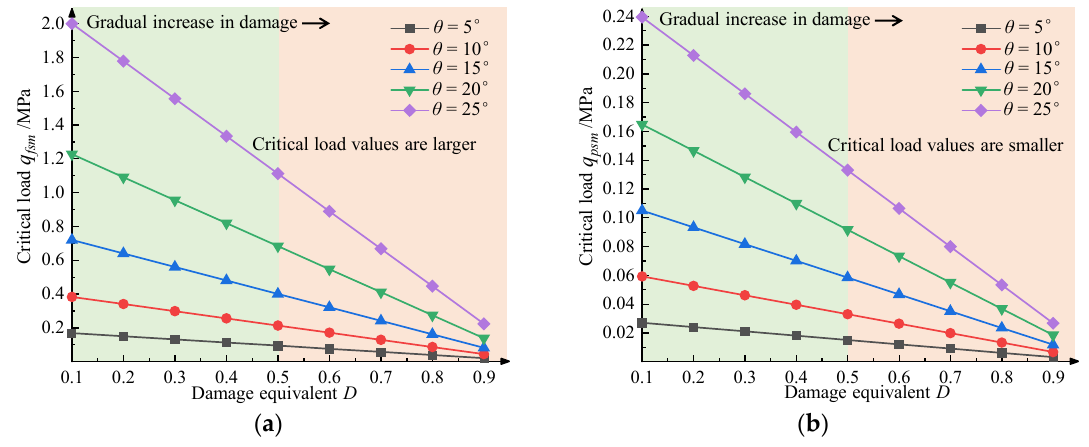
Figure 9. Critical load of sliding instability of the damaged key block. ( a ) First fracture of the damaged main roof ( b ) Periodic fracture of the damaged main roof.